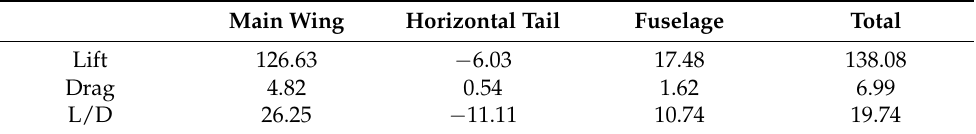
Table 3. CRM aircraft in cruise flight condition S 1 (M = 0.85 at 44,000 ft) with an angle-of-attack α = 2.05°. Breakdown of lift and drag forces (in tons), with their ratio.